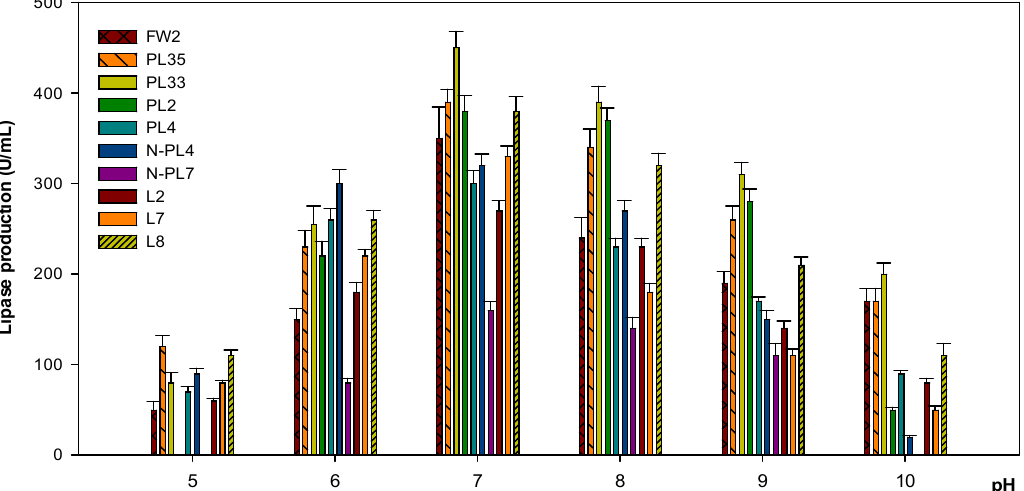
Figure 3. The effect of different pH values on lipase production. Bacterial cultures were incubated at 30 °C for 72 h. Experiments were performed in triplicate.